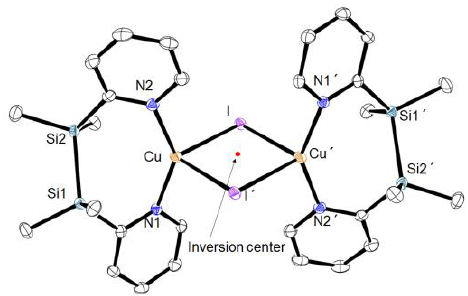
Figure 1. ORTEP drawing of complex 2 with thermal ellipsoids at the 50% probability level. Hydrogen atoms were omitted for clarity. Selected bond lengths and angles. Cu…Cu′ : 3.8761(3) Å . Cu‒I: 2.7405(3) Å. Cu‒I′: 2.9689(3) Å. I…I′: 4.1982(3) Å. Cu‒N1: 1.987(2) Å. Cu‒N2: 1.993(2) Å. Si1‒Si2: 2.3441(7) Å. Cu…Si1: 3.3453(5) Å. Cu…Si2: 3.2611(5) Å. Cu‒I‒Cu′: 85.417(7)°. I‒Cu‒I′ : 94.583(7)°. N1‒Cu‒N2: 140.45(6)° .